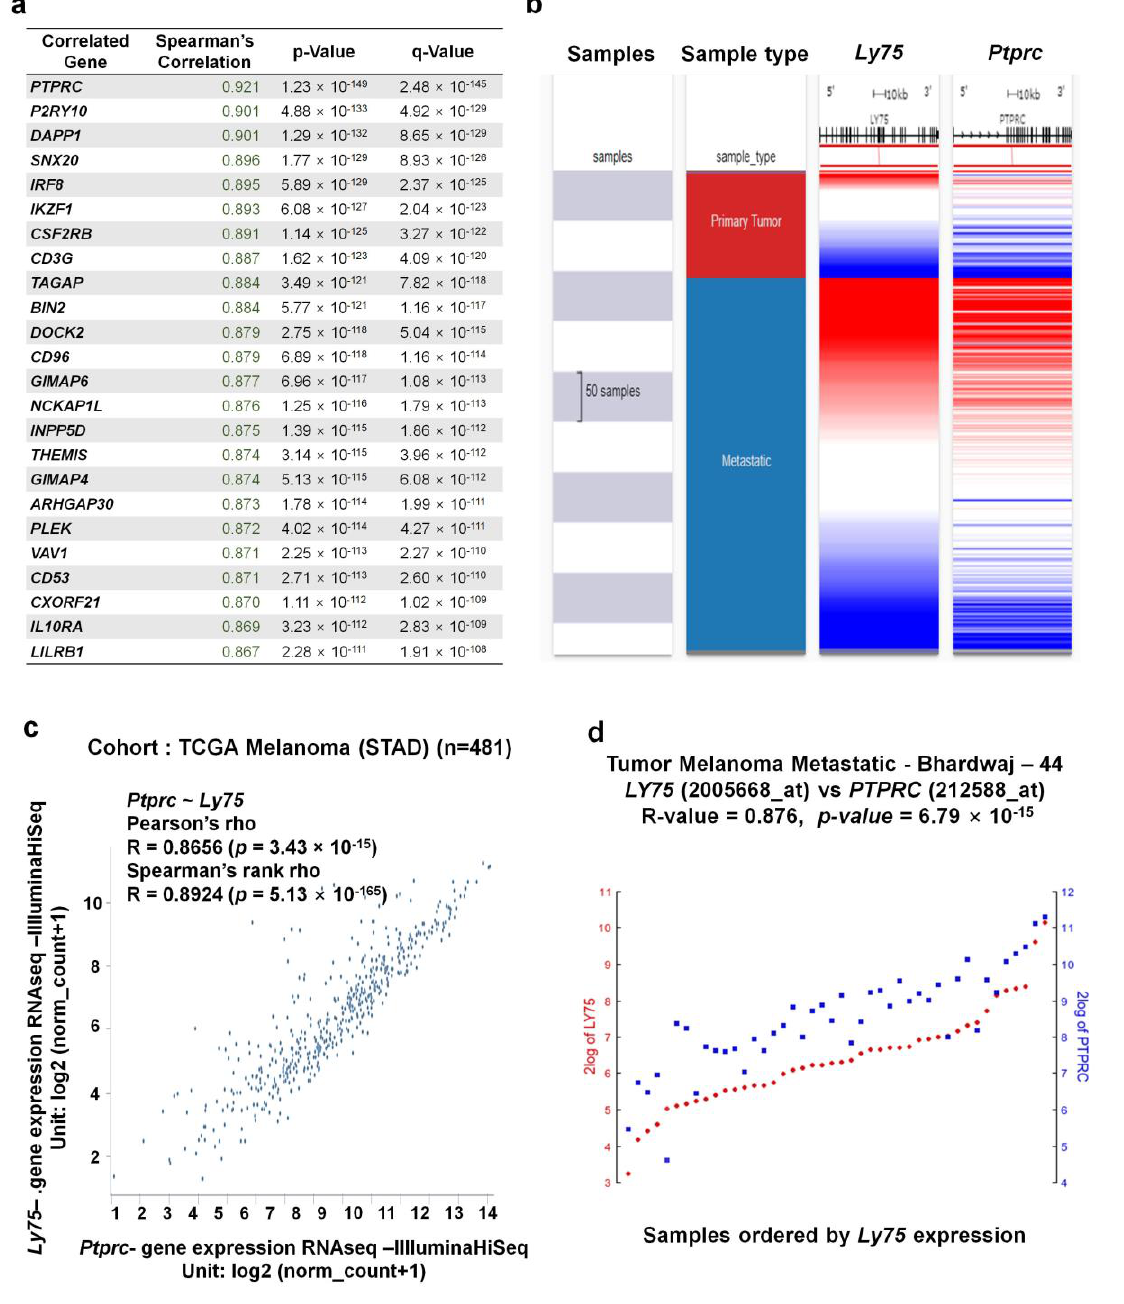
Figure 6. Co-expression genes of the Ly75 gene in SKCM. ( a ) The 24 genes that are the most co-expressed with Ly75 were analyzed using the TCGA-SKCM dataset and cBioportal ( b ) A heatmap of Ly75 and Ptprc mRNA expression in the TCGA-SKCM dataset, determined using the UCSC Xena Browser. ( c ) Correlation between Ly75 and Ptprc mRNA expression in the TCGA-SKCM dataset, as determined using the UCSC Xena Browser. ( d ) Correlation between Ly75 and Ptprc mRNA expression in the Tumor Melanoma Metastatic - Bhardwaj - 44 dataset, as determined using the R2